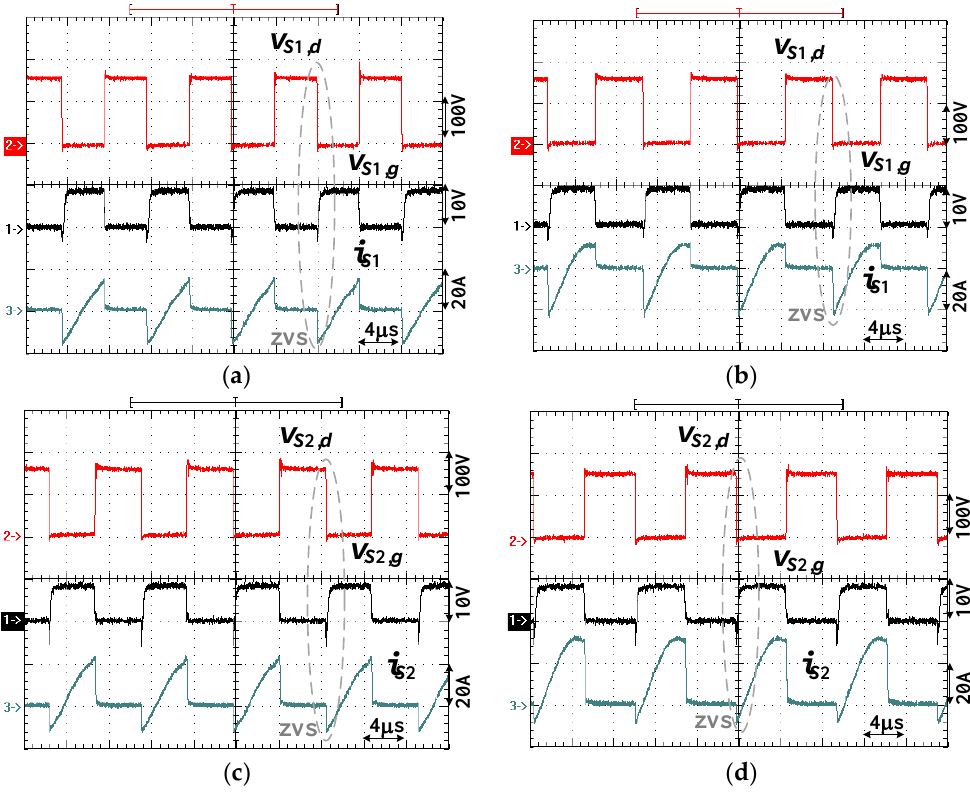
Figure 13. Experimental results of power switches S 1 and S 2 under high voltage mode operation and V in = 80 V: ( a ) v S 1 , g , v S 1 , d , i S 1 at 20% rated power; ( b ) v S 1 , g , v S 1 , d , i S 1 at 100% power; ( c ) v S 2 , g , v S 2 , d , i S 2 at 20% rated power; ( d ) v S 2 , g , v S 2 , d , i S 2 at 100% power.